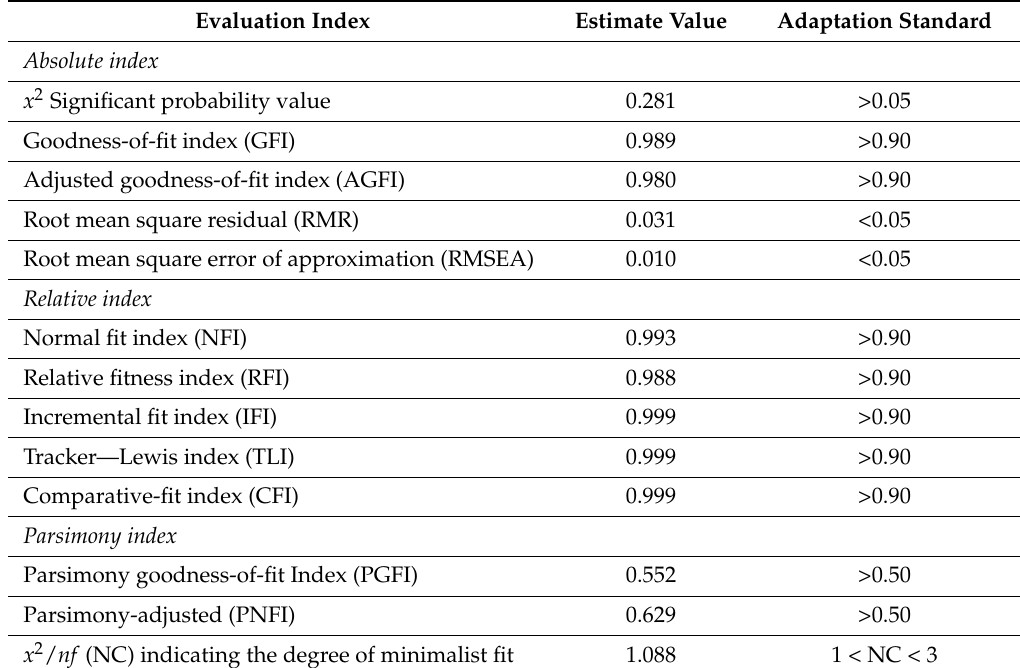
Table 6. Data of the variables via SEM